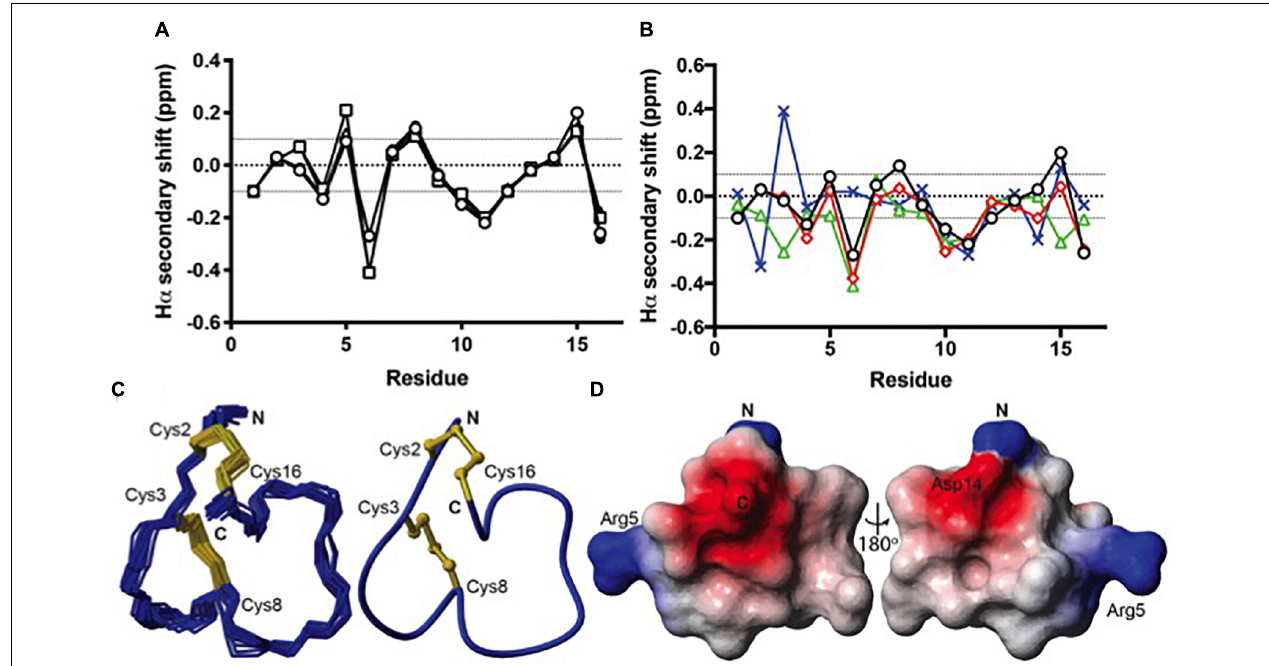
FIGURE 4 | Structural analysis of the ribbon disulfide isomers of TxIA and analogs. (A) H α secondary shift values for recombinant TxIA (open circles), [R5D]TxIA (squares), [R5N]TxIA (triangles), and synthetic ribbon TxIA (closed circles) at 7 ◦ C. Please note that due to the identity of the peptides, the secondary shifts overlap and most data points (filled circles) are hardly visible (B) A comparison of the H α secondary shifts for ribbon TxIA (black) with the H α secondary shifts of ribbon (red), globular (green) and beads (blue) isomers of Pn1.2. The values for ribbon TxIA most closely match those of ribbon Pn1.2, especially in the N-terminal region. (C) Left panel: ensemble of the 20 lowest energy structures for ribbon TxIA. The peptide backbone is in blue and the disulfides are in gold. Right panel: the mean structure of ribbon TxIA calculated from the ensemble. The structure is shown in ribbon format with disulfide bonds in ball and stick. The N- and C-termini are indicated and the cysteines are labeled. (D) Electrostatic surface of ribbon TxIA (PDB ID 6OTA) highlighting the negatively charged regions (red) corresponding to the C-terminal acid and Asp14, and the positively charged regions (blue) corresponding to the N-terminus and the side chain of